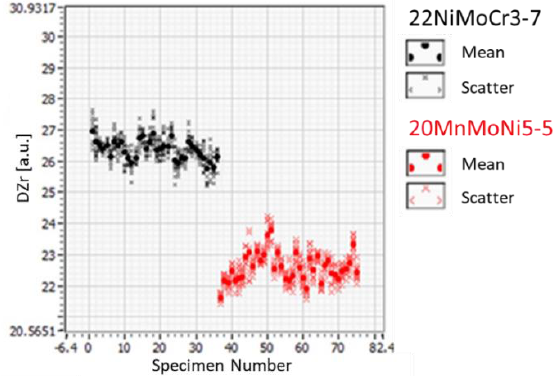
Figure 7. Preliminary micromagnetic measurements on all specimens, feature DZr.